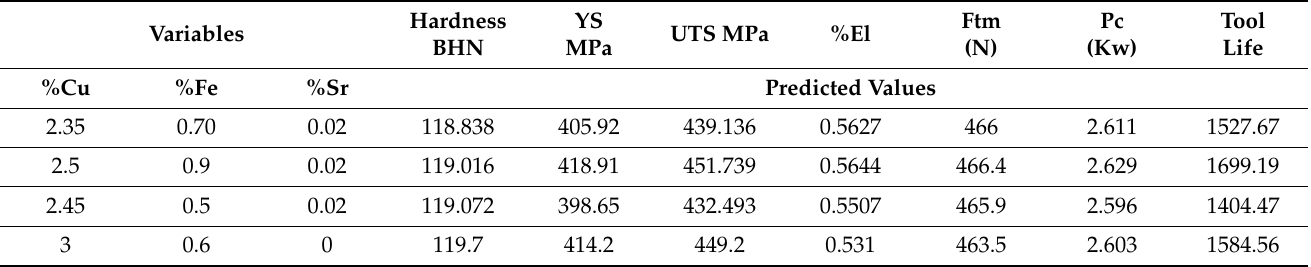
Table 6. Mechanical and machining properties values calculated using Equations (6)–(12).